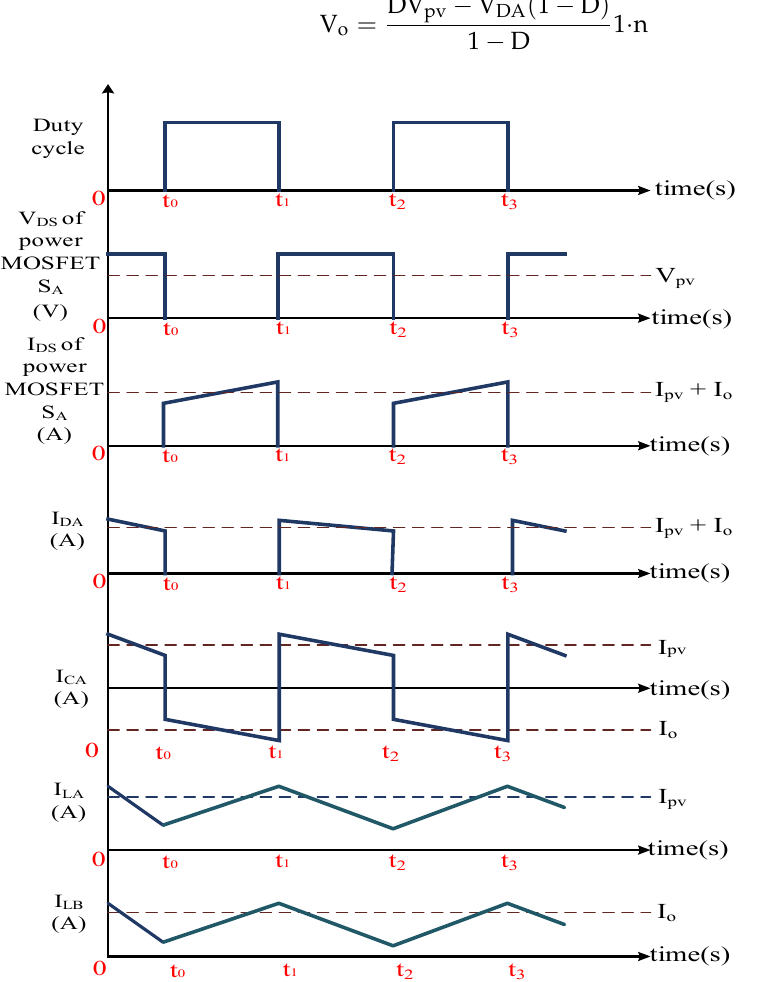
Figure 5. Voltage and current waveforms show V DS , I DS , I DA , I CA , I LA , and I LB along with the duty cycle of the proposed IIABB converter.